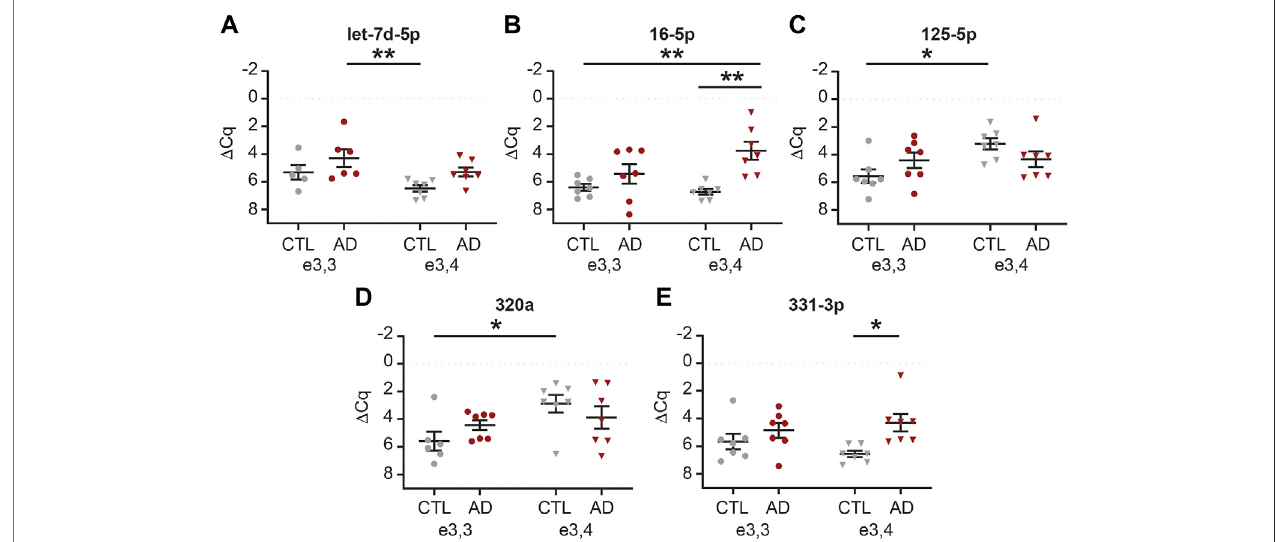
FIGURE 9 | MiRNAs are differentially expressed based on APOE status and disease state in female CSF EVs. Normalized Cq ( Δ Cq) values for fi ve miRNAs that demonstrate a signi fi cant effect of APOE genotype on expression levels within AD and/or CTL female CSF EVs. (A) Let-7d-5p was signi fi cantly increased in AD APOE- e3,3 vs. CTL APOE-e3,4. (B) miR-16-5p was signi fi cantly increased in AD APOE-e3,4 vs. CTL APOE-e3,3 and -e3,4. (C) miR-125b-5p, and (D) miR-320a were signi fi cantly increased in CTL APOE-e3,4 vs. CTL APOE-e3,3. (E) miR-331-3p was signi fi cantly increased in AD APOE-e3,4 vs. CTL APOE-e3,4. Data shown as the mean ± SEM and analyzed by two-way ANOVA followed by Tukey ’ s multiple comparisons post hoc tests, * p < 0.05 and ** p < 0.01.